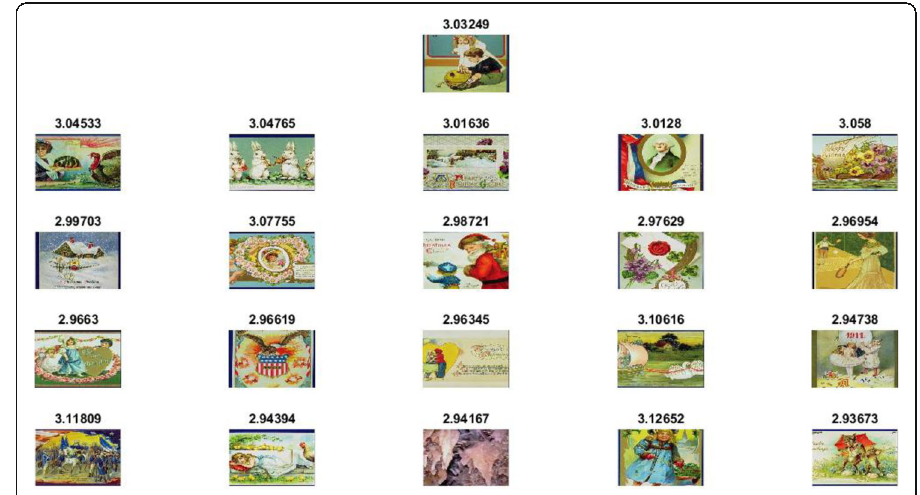
Fig. 12 Semantic category “ Postcard ” of the Corel 1500 dataset shows retrieved images as a response of the query image (first row)